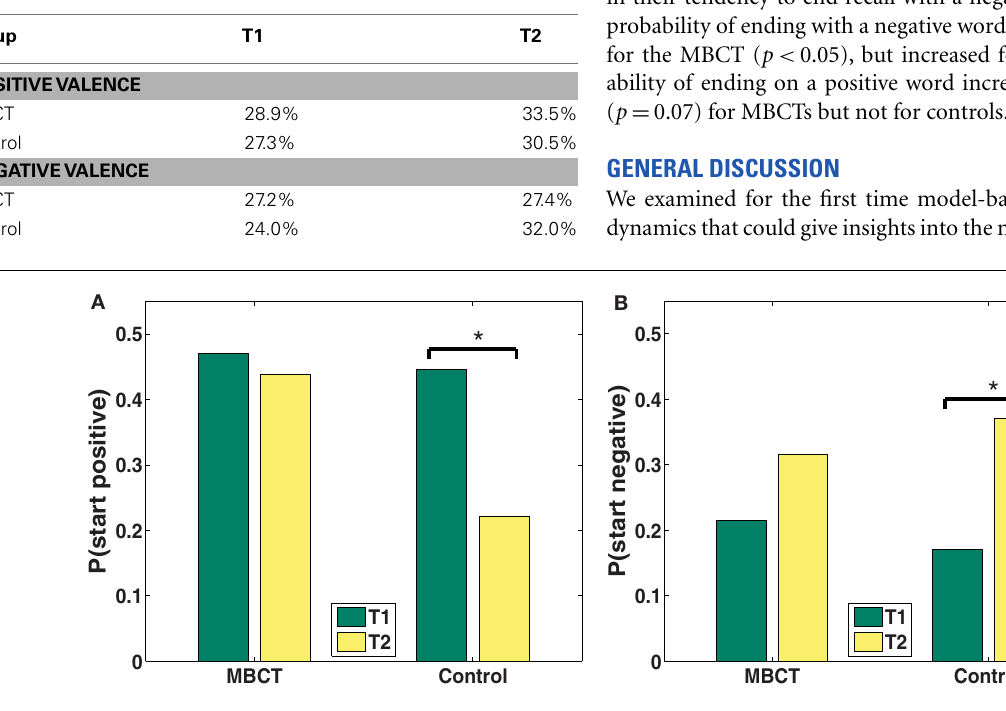
FIGURE 2 | (A,B) Changes in probability of first recall fromT1 toT2 by valence category ( A : positive; B : negative). * p <